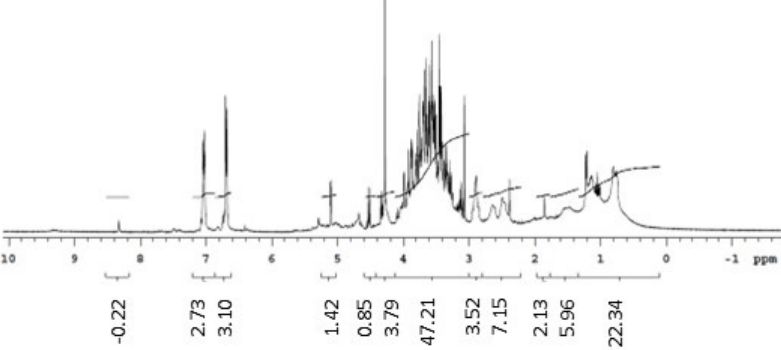
Figure 9. 1 H NMR spectrum (D 2 O, 300 MHz) of the standard saponin from Sigma.